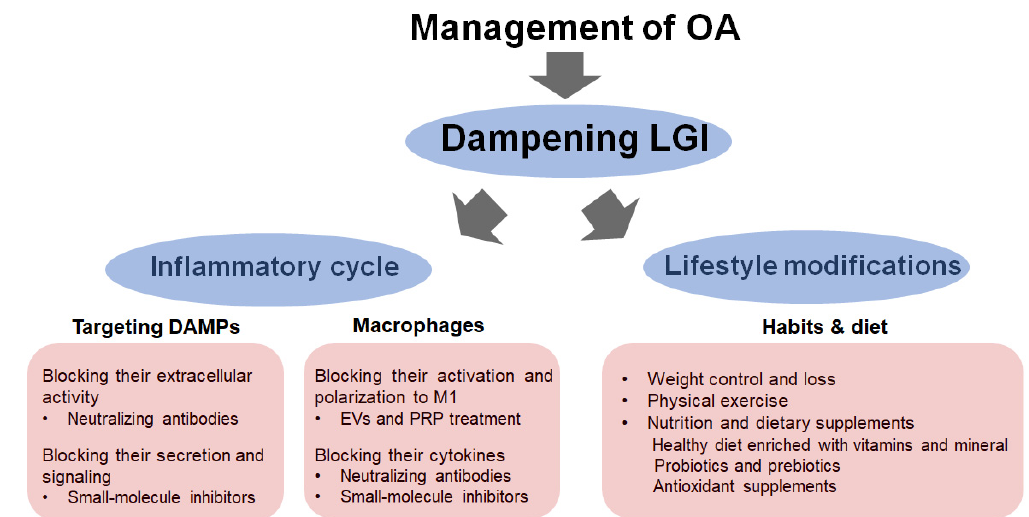
Figure 4. Targeting LGI for treatment of OA. Dampening inflammation by targeting the inflammatory cycle includes blocking the extracellular activity and production of DAMPs, reducing macrophage activation and polarization, and blocking inflammatory cytokines, TNF- α , IL-1, and IL-6. Lifestyle modifications include weight loss, exercise and nutrition, and dietary supplements.